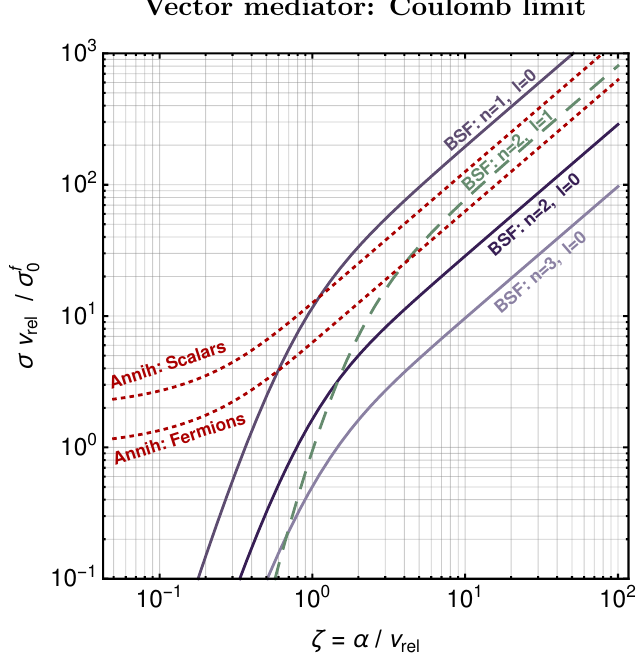
Figure 2 . Velocity dependence of the cross-sections for the radiative formation of bound states, by a pair of particles charged under an unbroken dark U(1) force. The solid lines correspond to capture into zero angular momentum bound states, with n denoting the principal quantum number. The dashed line is the total cross-section for capture into any n = 2 ; ‘ = 1 state (i.e. summed